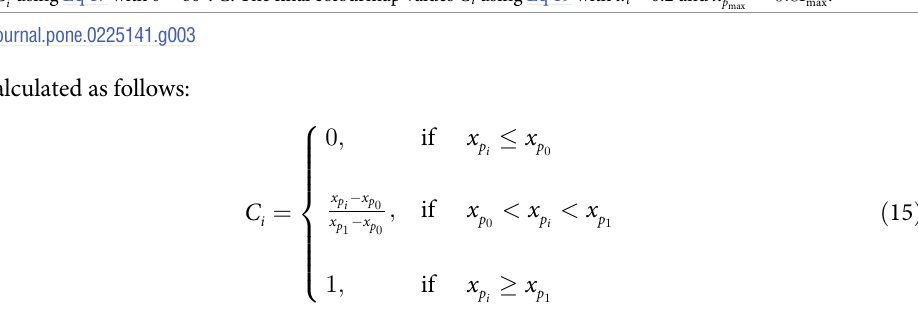
Fig 3. The effect of the colour mapping model on possible colocalisation intensities. Using Fig 2 as a reference, we consider a specific regression line, shown as a red dashed line, with ^ b calculated for each possible colocalisation intensity q yellow corresponds to C i = 1. For clarity, both thresholds T ch 1 and T ch 2 are zero in this example. A: The colourmap values C i using Eq 15. B: The colourmap values C 0